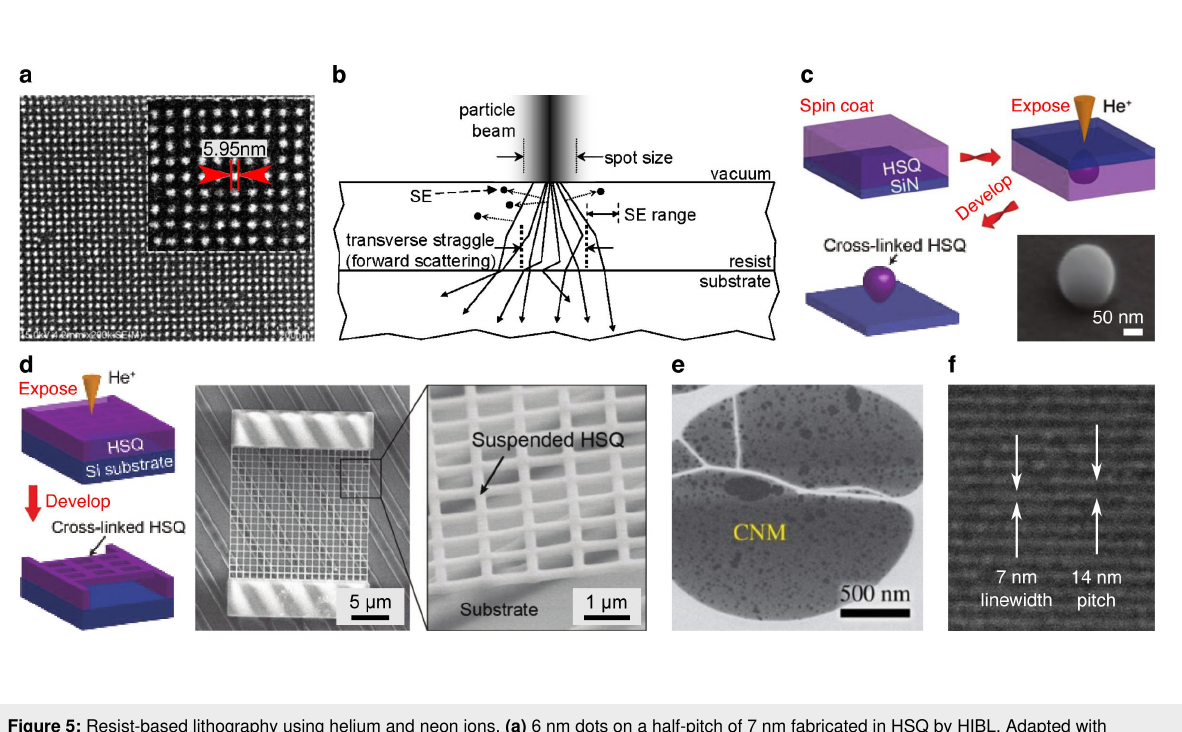
Figure 5: Resist-based lithography using helium and neon ions. (a) 6 nm dots on a half-pitch of 7 nm fabricated in HSQ by HIBL. Adapted with permission from [106]. Copyright 2009 American Vacuum Society. (b) Schematic summarizing the beam–sample interactions involved in resist expo- sure (ion backscatter from the resist–substrate interface is negligible). Reprinted with permission from [107]. Copyright 2009 American Vacuum Society. (c) Procedure for the 3D measurement of the point-spread function for HIBL using a through-membrane exposure technique: The SEM image shows a cross-linked volume of HSQ upon development of the resist following the point exposure. Adapted from [108]. Copyright © 2018 WILEY-VCH Verlag GmbH & Co. KGaA, Weinheim. Used with permission from Cai et al., 3D Volumetric Energy Deposition of Focused Helium Ion Beam Lithogra- phy: Visualization, Modeling, and Applications in Nanofabrication, Advanced Materials Interfaces, John Wiley and Sons. (d) Fabrication of a suspended mesh structure by direct exposure of the resist from the front side. Adapted from [108]. Copyright © 2018 WILEY-VCH Verlag GmbH & Co. KGaA, Weinheim. Used with permission from Cai et al., 3D Volumetric Energy Deposition of Focused Helium Ion Beam Lithography: Visualization, Modeling, and Applications in Nanofabrication, Advanced Materials Interfaces, John Wiley and Sons. (e) Carbon nanomembrane (CNM) fabricated by HIBL of aromatic self-assembled monolayers. Reprinted from [112]. Copyright 2014 Zhang et al., licensed under a Creative Commons Attribution 4.0 International License, http://creativecommons.org/licenses/by/4.0/. (f) 7 nm lines on a half-pitch of 7 nm fabricated in HSQ by NIBL. Adapted with permission from [113]. Copyright 2011 American Chemical Society. The content of (a), (b), (c), (d) and (f) is not subject to CC BY